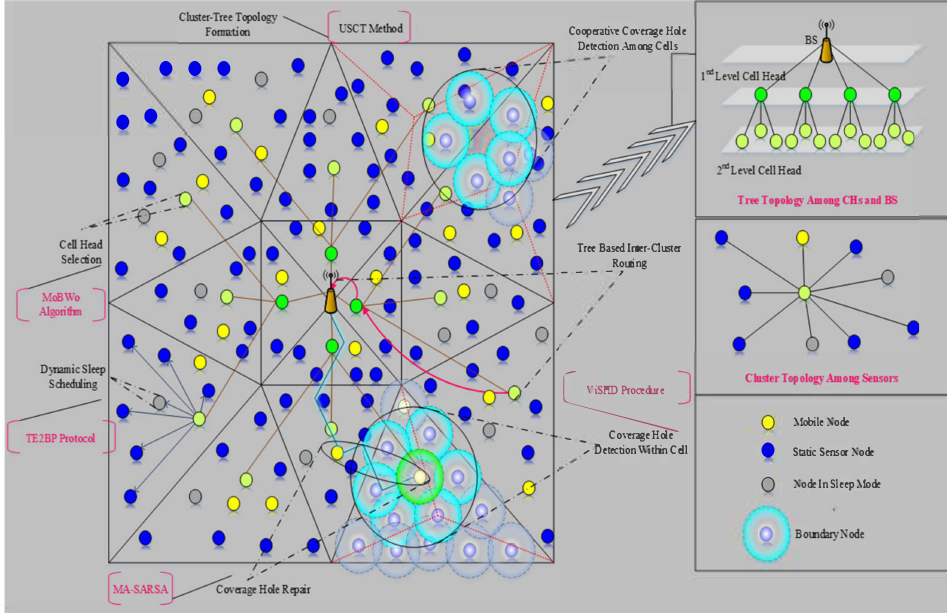
Figure 1. Network Architecture.